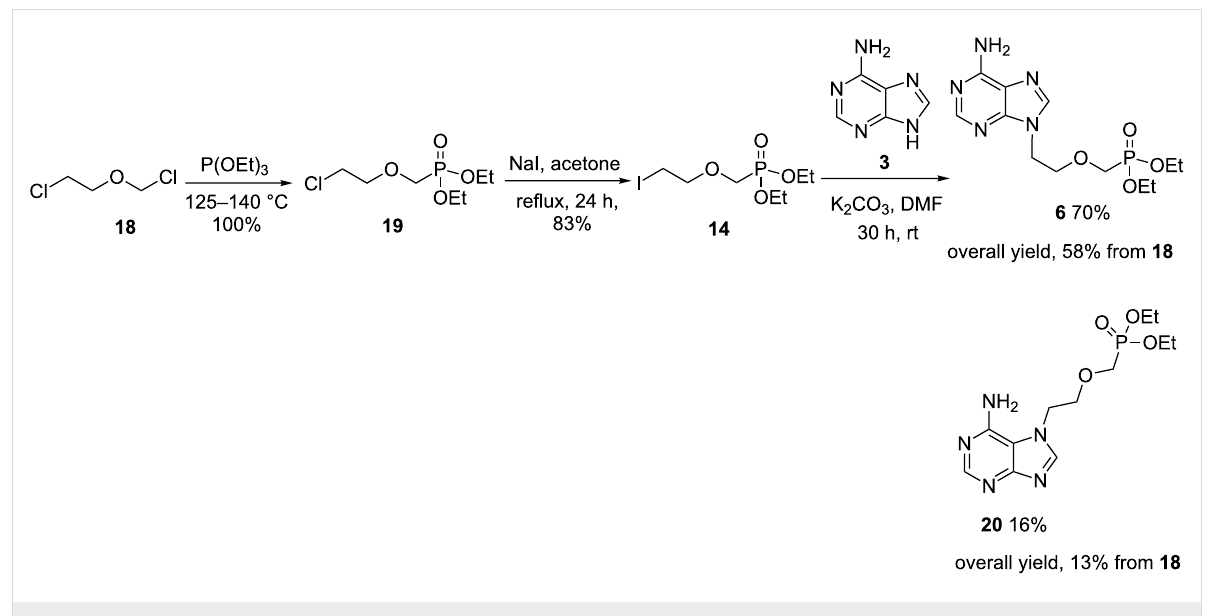
Scheme 4: Synthesis of 6 and 20 via iodide 14 .